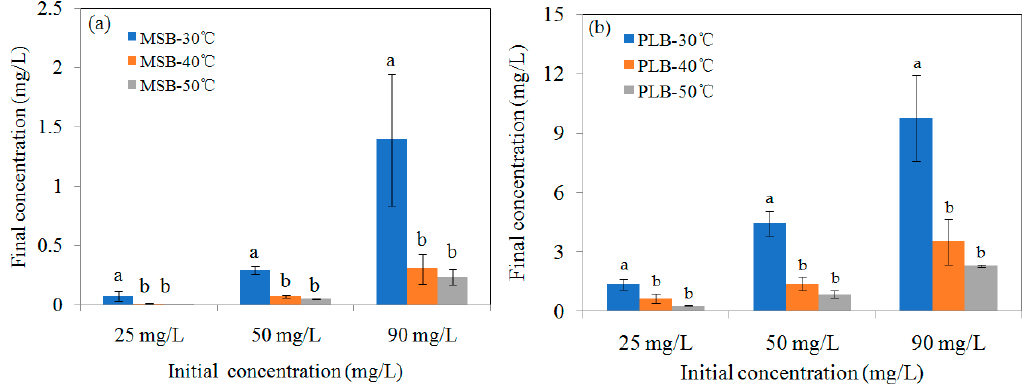
Figure 9. Effect of temperature on adsorption efficiency of Cd by ( a ) MSB500 and ( b ) PLB500 (pH 6.0 for MSB500, pH 6.5 for PLB500).